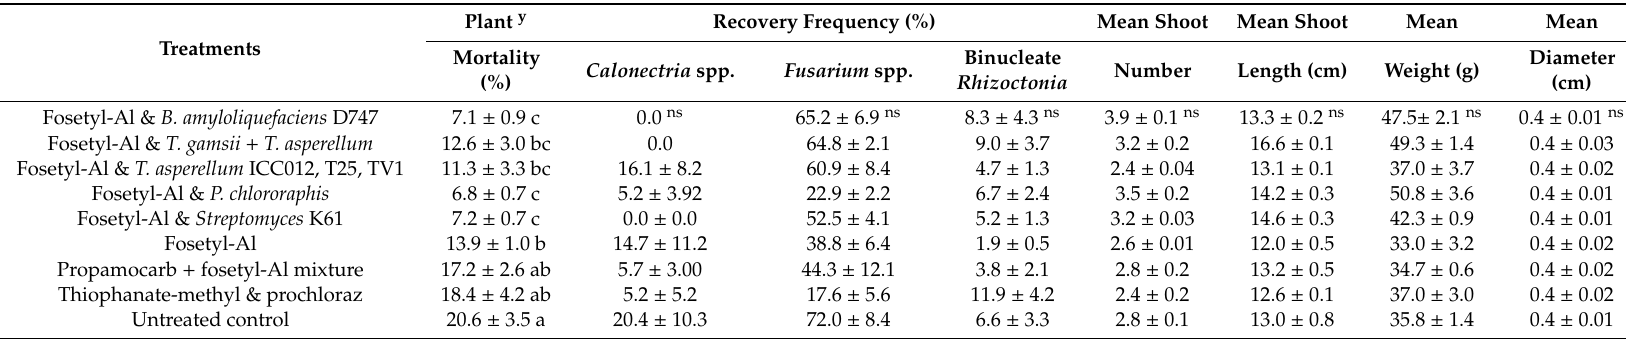
Table 3. E ffi cacy of treatments in reducing milkwort decline and agronomic parameters of plants in experiment III under natural infection after 5 months.